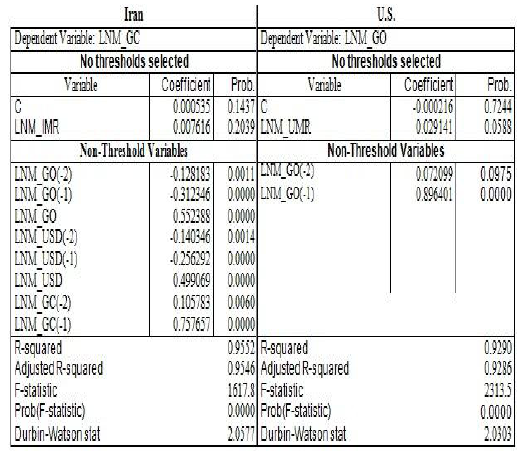
Table 11: Manually Applying the Regimes to the Relationship of the Monthly Returns of the U.S. and Iran Stock Markets with